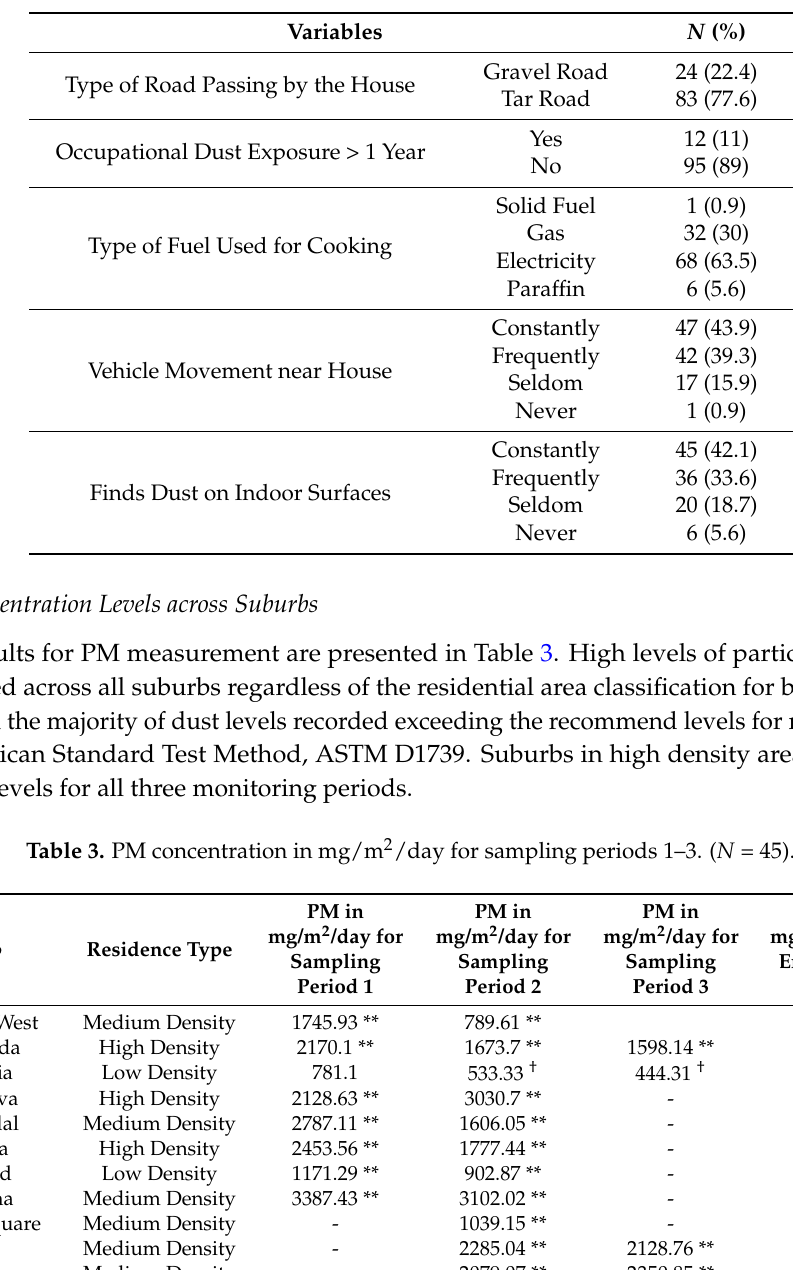
Table 2. Relative frequency of environmental related exposure to Particulate Matter